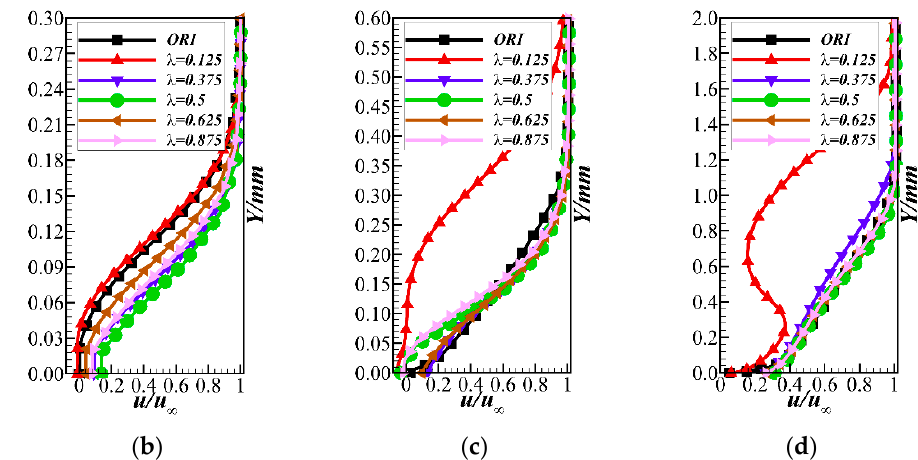
Figure 15. Change in the boundary layer along the axial direction. ( a ) 20% b x ; ( b ) 30% b x ; ( c ) 60% b x ; ( d ) 90% b x .